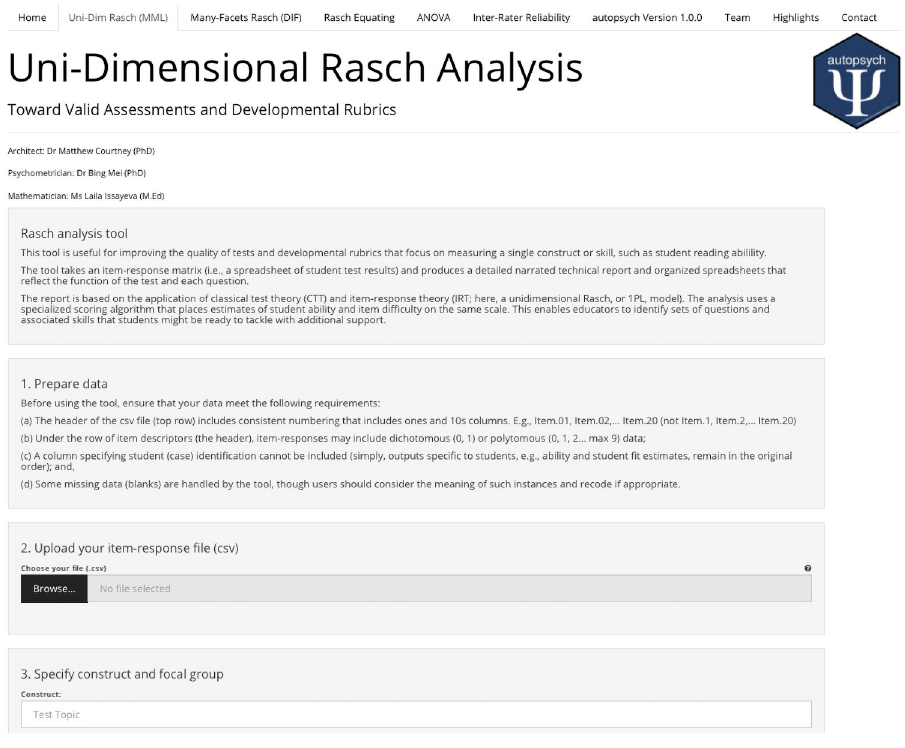
Fig 2. Uni-dimensional Rasch